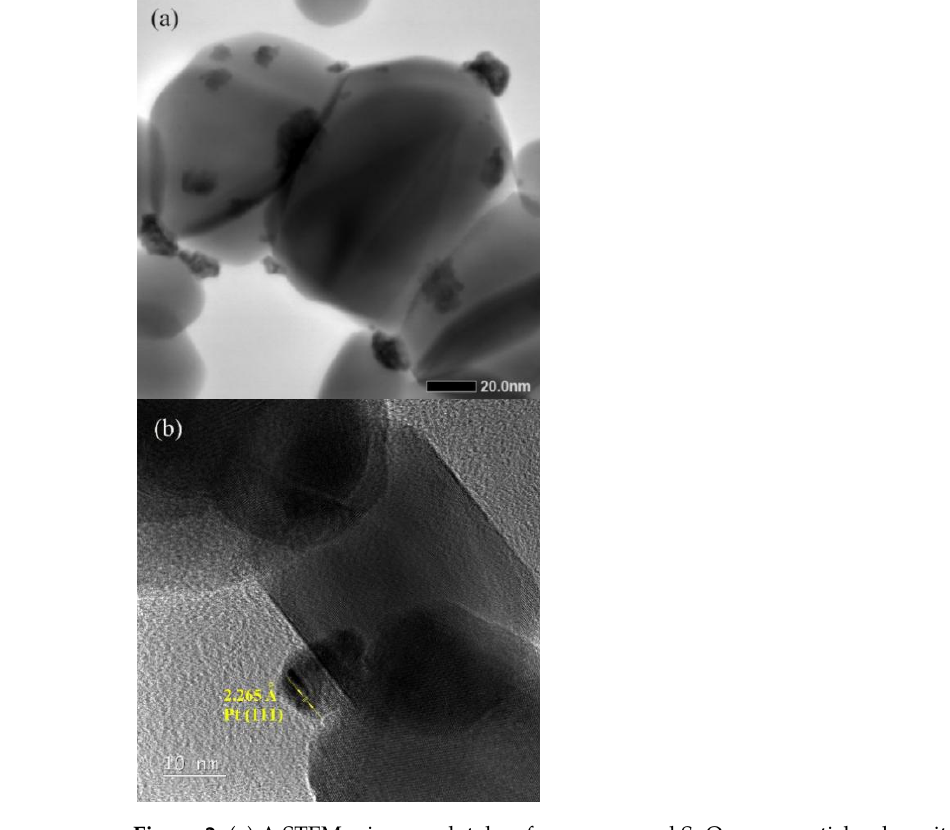
Figure 2. ( a ) A STEM micrograph taken for as-prepared SnO 2 nanoparticles deposited with 2.50 wt% Pt. ( b ) A HRTEM micrograph taken on a Pt nanoparticle.